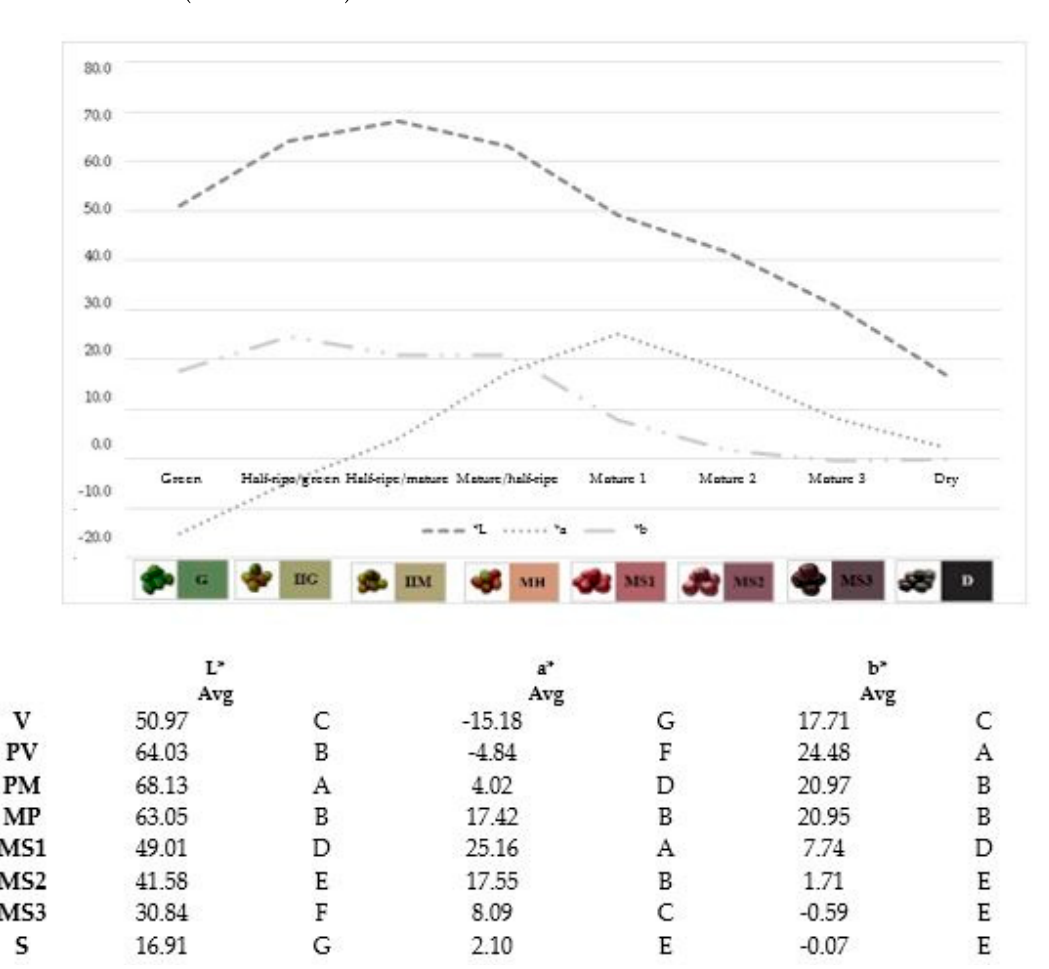
Figure 2. Colorimetry of coffee fruit by ripening stage. Different letters indicate a difference between means according to Duncan’s test at 5%.